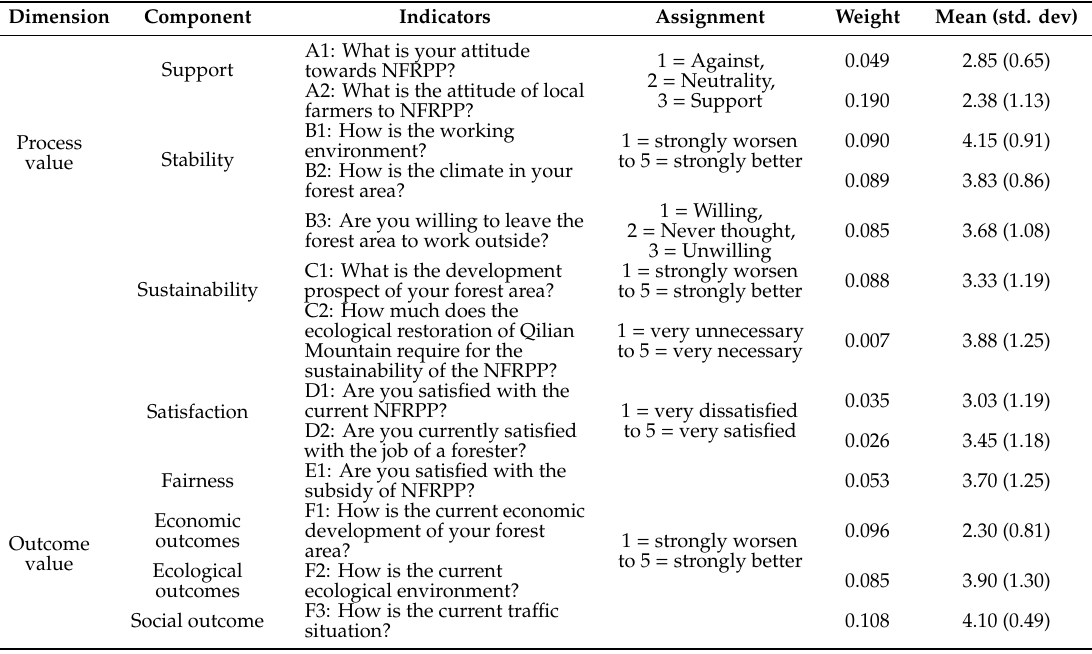
Table 2. Index system to evaluate the performance of natural forest resource protection project